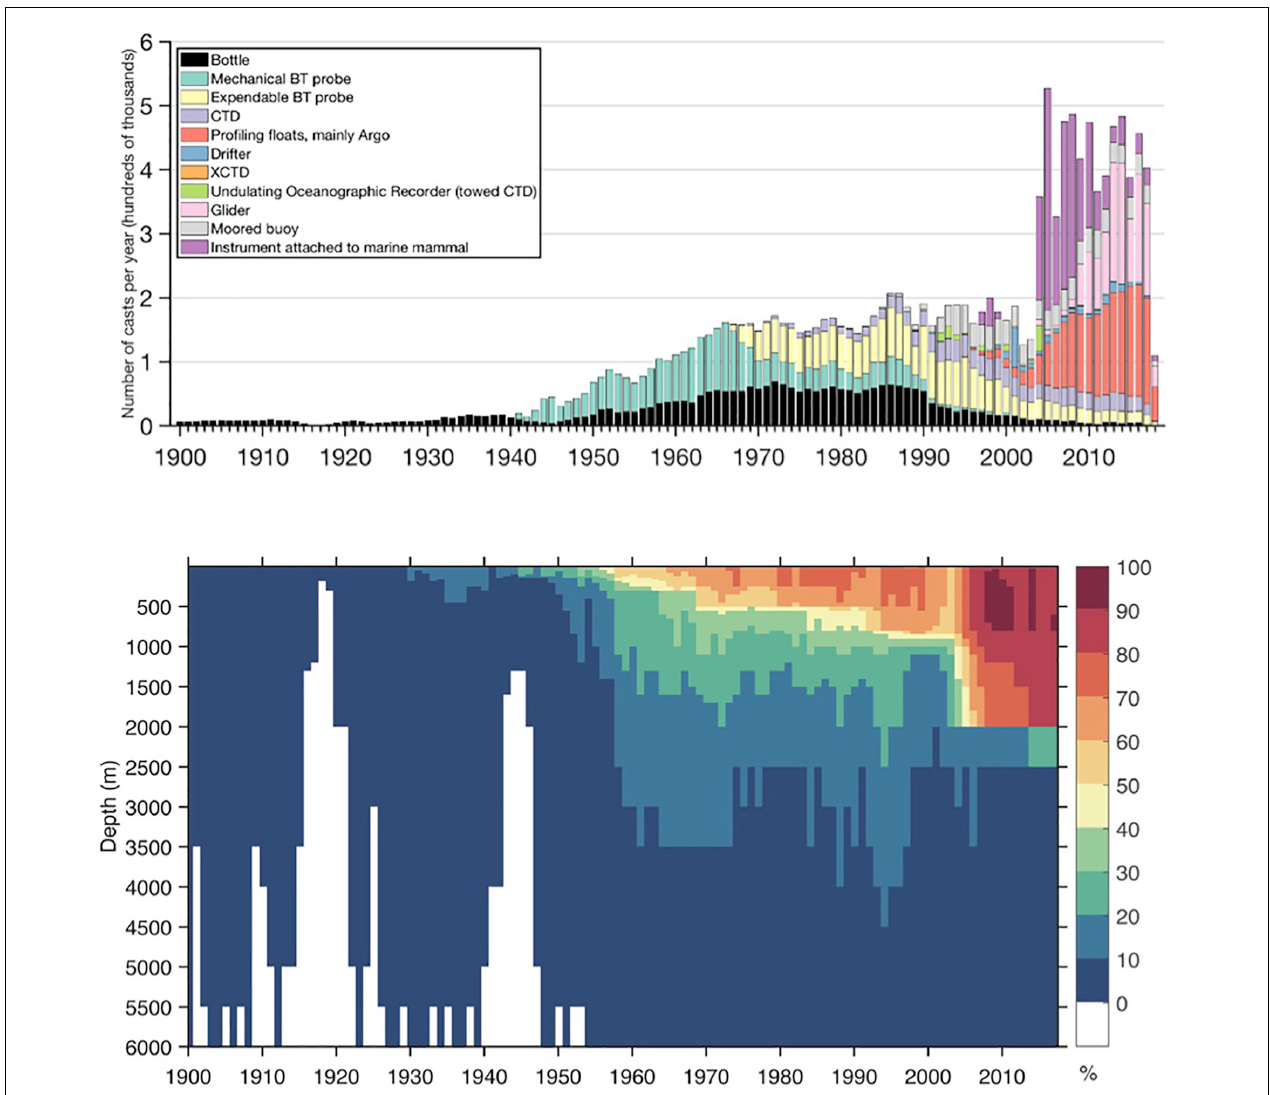
FIGURE 2 | (Upper) Number of subsurface ocean temperature profiles per year by instrument type 1900–2017. [BT, Bathythermograph; CTD, Conductivity- Temperature-Depth; XCTD, Expendable CTD]. (Lower) Percentage (%) of data coverage for 3 × 3 boxes over the global ocean area from 5 to 6000